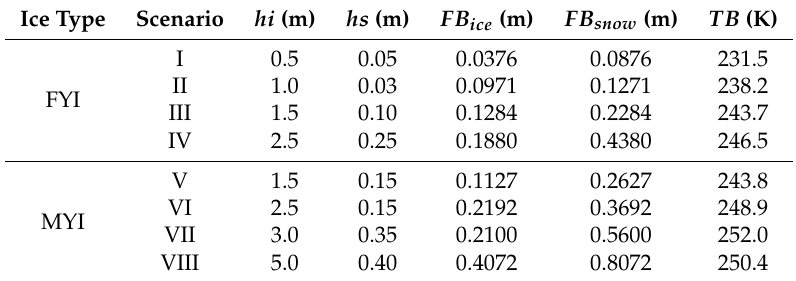
Table 1. Sea ice parameters ( hi and hs ) and observed parameters ( FB ice , FB snow and TB ) for 8 typical retrieval scenarios for the Arctic.